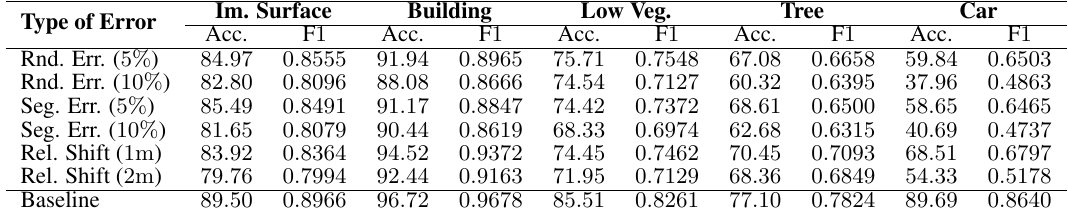
Table 2. Comparison of evaluation metrics (accuracy and F1 score for the test dataset) for the models trained with different type and amount of label errors introduced to Potsdam dataset. The last row of the table highlights the metrics for baseline model.